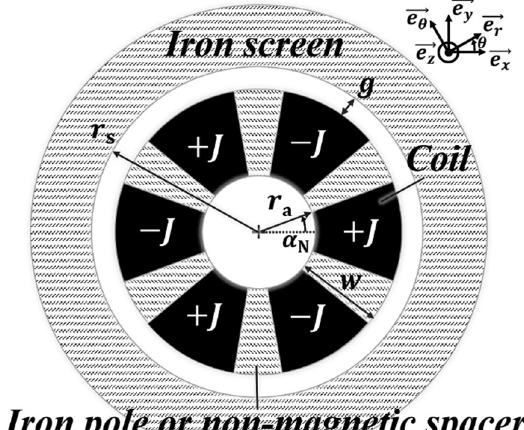
FIG. 1. Sketch of a 2 N -poles sector coil with iron screen and optional iron poles for N ¼ 3 (i.e.,